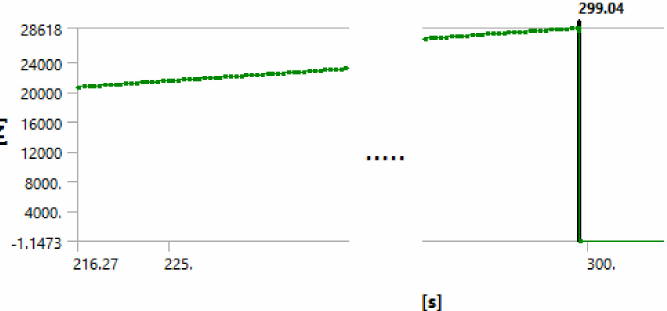
Figure 10. Debonding moment observed on the reaction force in the piston showing abrupt change of piston force by the green line at time stamp 299.04